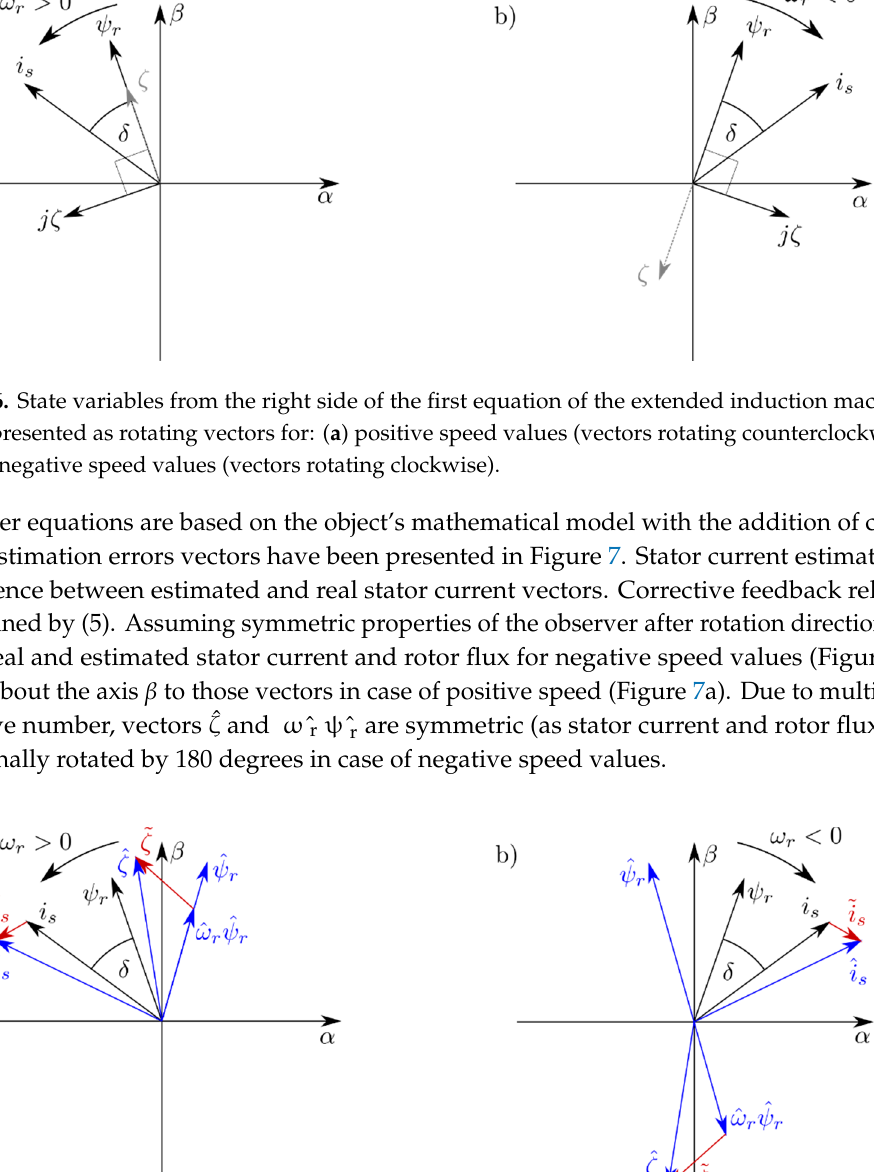
11 of 23 Figure 5. Poles placement of the observer in the function of the rotor speed under nominal rotor flux module and no load. To explain and possibly find a solution to observer properties asymmetry after rotation direction change, the extended induction machine model symmetry is analyzed first. Vectors presented in the first equation of the extended induction machine model (6) are shown in Figure 6. If the machine is operating as a motor, stator current vector precedes rotor flux vector. In the case of positive rotation speed (all vectors rotate counterclockwise), vector ζ coincides with the rotor flux, as by definition (5) ζ is formed by multiplying rotor flux vector by a scalar rotor speed. Multiplication of a vector by imaginary number j rotates the vector by +90 degrees, therefore vector j ζ precedes rotor flux vector by 90 degrees. In the case of a negative speed (all vectors rotate clockwise), vector ζ is formed by multiplying rotor flux vector by a negative value, hence it has the opposite direction to the rotor flux vector. Rotated vector ζ ( j ζ ) again precedes the rotor flux vector by 90 degrees. Terms on the right side of the first equation of the extended induction machine model are formed by multiplying black vectors presented in the figure by a constant value that only scales the length of the vector. The greyed-out, not